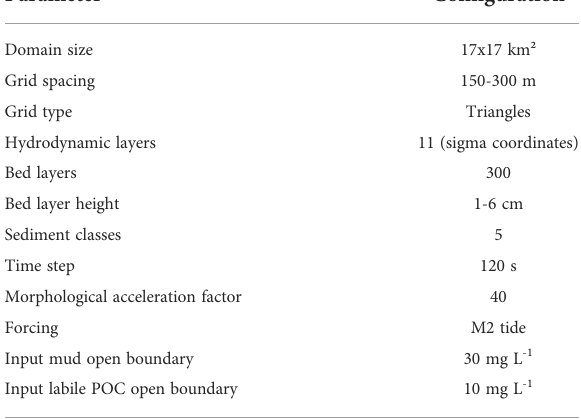
TABLE 1 Con fi guration of model